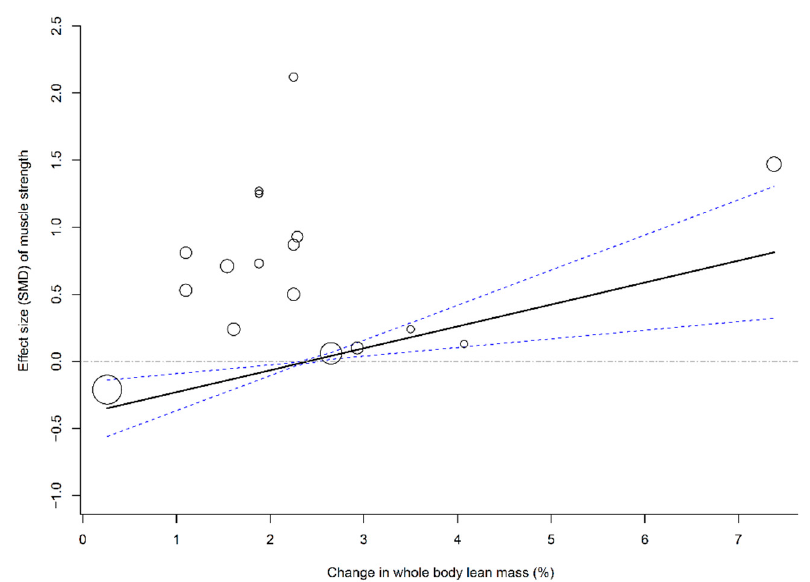
Figure 3. Multivariate meta-regression between percentage change in lean body mass and effects of PS plus MSE on leg strength. Each circle represents an independent comparison. The size of each circle is proportional to that study’s weight (inverse variance weighted). The regression prediction is represented by the solid line for effect size (SMD) of leg strength. Dotted lines represent the 95% CI. The metaregression model was adjusted for age, methodological quality, and follow-up time of each comparison. PS, protein supplementation; MSE, muscle strengthening exercise; SMD, standard mean difference.